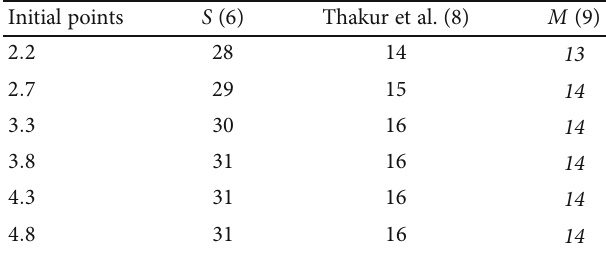
= n / ð n + 5 Þ 10/9 and β Table 3: α n iterations required to obtain the fi xed